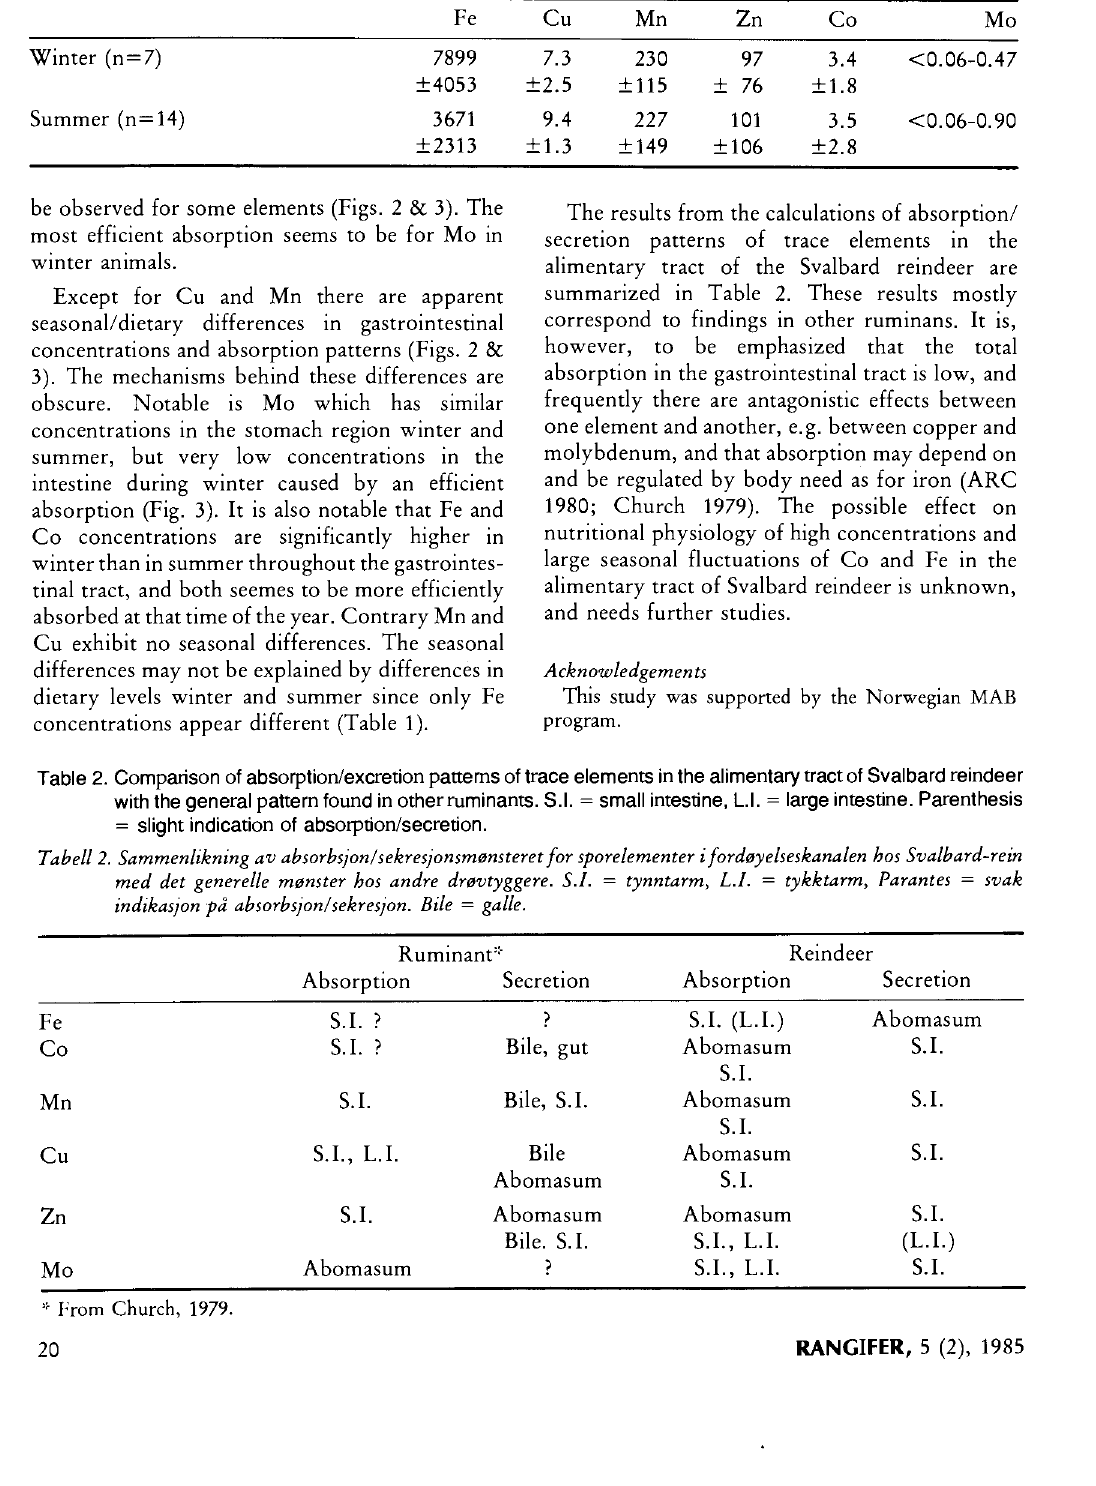
Table 1. Trace elements (mg/kg dry matter ± S.D.) in reindeer forage plants from Adventdalen, Svalbard. (From Staaland et al. 1983. Tabell 1. Sporstoffer (mg/kg tørrstoff ± S.D.) i reinbeiteplanter fra Adventdalen, Svalbard. (Fra Staaland et al. 1983).